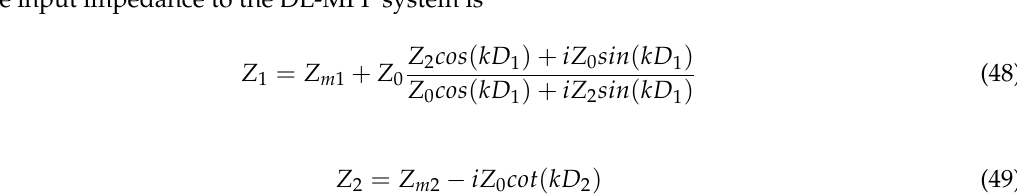
Figure 24. Sketch of a DL-MPP at normal incidence.